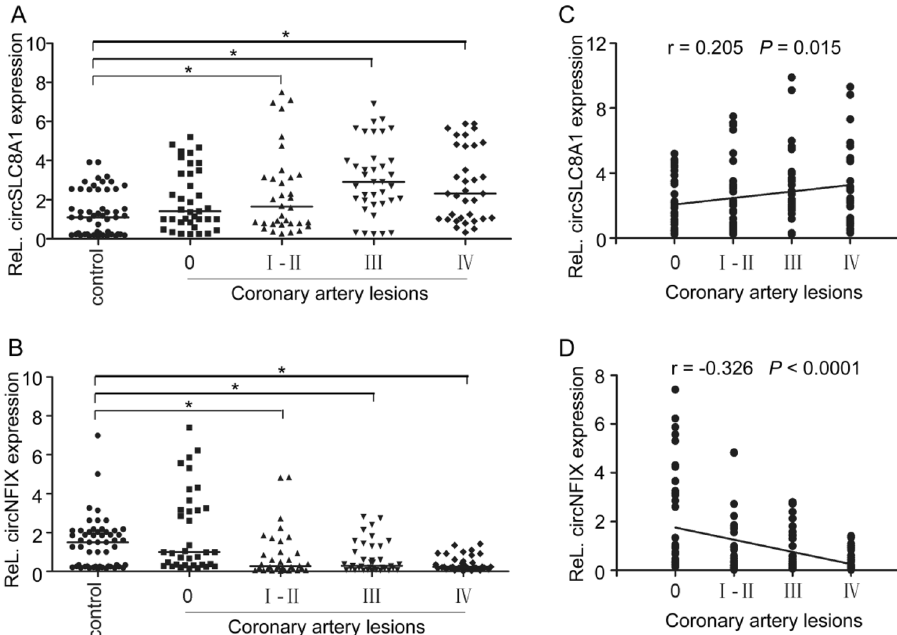
Figure 6. Correlation between circRNA levels and coronary stenosis grades. ( A, B) Total circSLC8A1 and circNFIX levels in cardiac tissues supplied by three coronary arteries (numbers in each group: control = 54; 0 = 36; I—II = 34; III = 37; IV = 34). The circRNA level in cardiac tissues was calculated based on the mean ΔCT value for each coronary artery in controls. Differences between groups were analyzed using one-way analysis of variance (ANOVA); post hoc analyses were performed using Dunnett’s multiple comparison test, * P < 0.05. (C, D) Spearman plots of circSLC8A1 and circNFIX levels and coronary stenosis